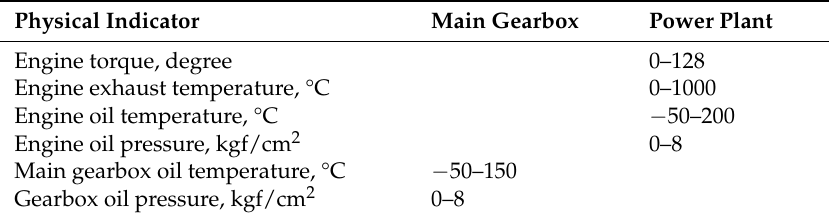
Table 1. Key physical